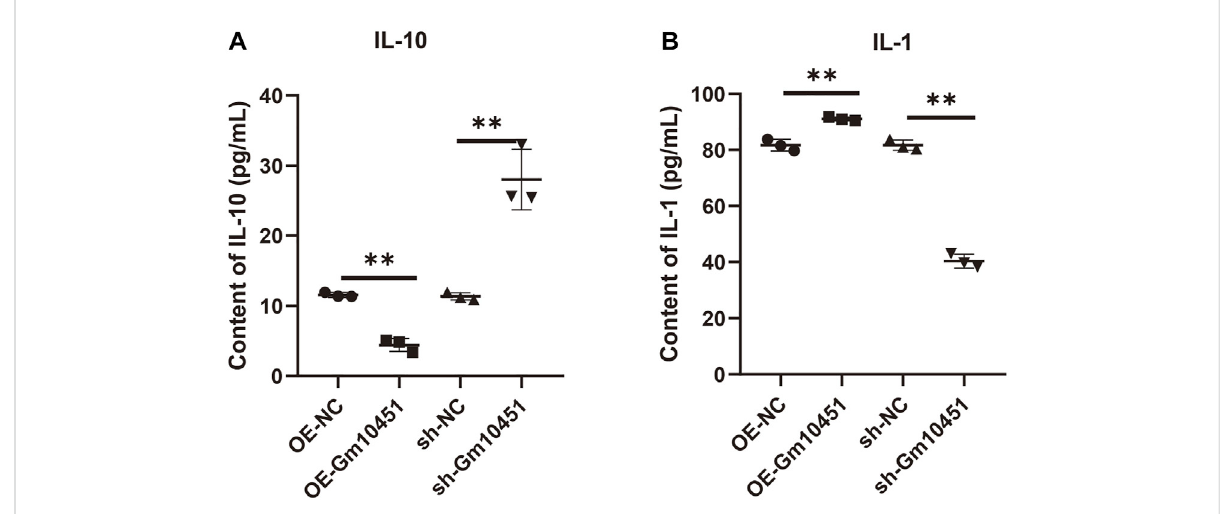
High levels of Gm10451 increased the secretion of in fl ammatory factors. The expression levels of IL-10 and IL-1 were determined by ELISA. (A) Determination on IL-10 expression using the ELISA method. (B) Determination on IL-1 expression using the ELISA method. N = 3. **, p <